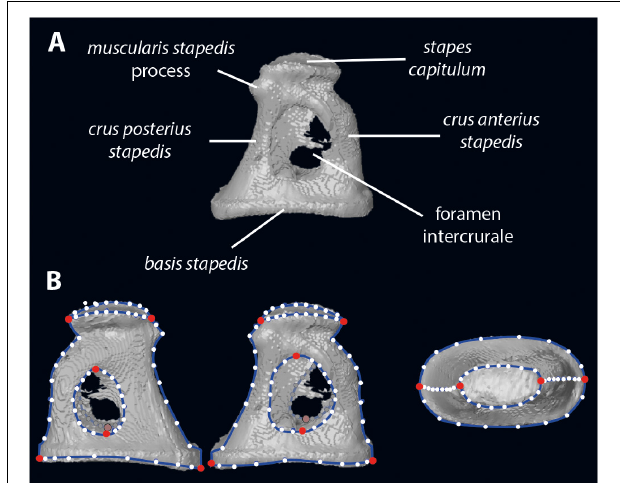
FIGURE 1 | Stapes morphology (based on Hydropotes inermis NMB 9892). (A) anatomical nomenclature; (B) landmark set (in red landmarks of type 2 and white semilandmarks on blue curves). 3D specimen is in Supplementary Data S1